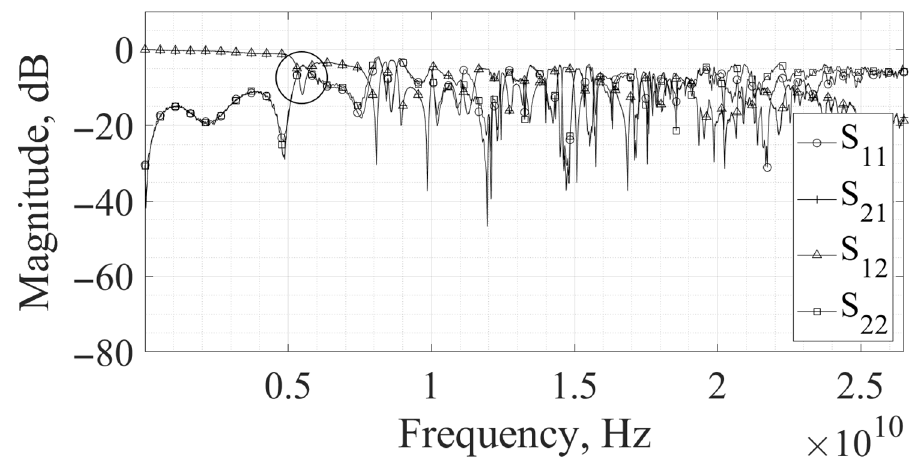
Figure 7. S parameters of a dielectric resonator with a resonant frequency of 6.75 GHz placed on the MSL. The circle highlights the minimum of the transmission coefficient corresponding to the resonance.